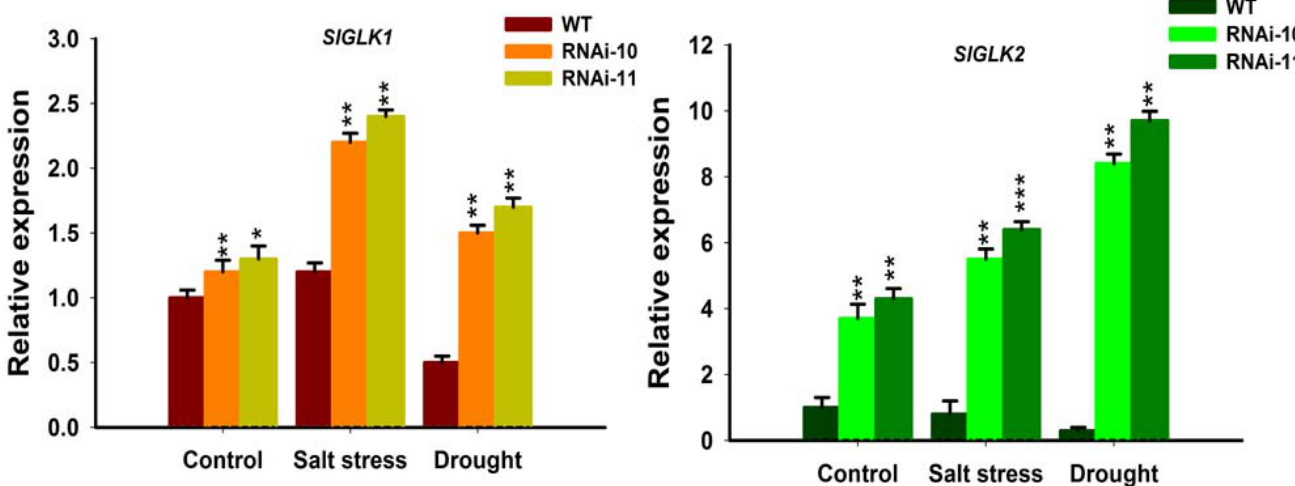
Figure 10. Enhanced expression of chlorophyll biosynthesis-related genes in SlGRAS10 -RNAi under stress conditions. Expression analysis of SlGLK1 and SlGLK2 genes in SlGRAS10 -RNAi (L10, L11) and WT after control, salt, and drought stress treatments. The date represents the mean ± SE of three independent replicates. * , ** indicates a significant difference ( p < 0.05, p < 0.01) between transgenic and wild-type plants.